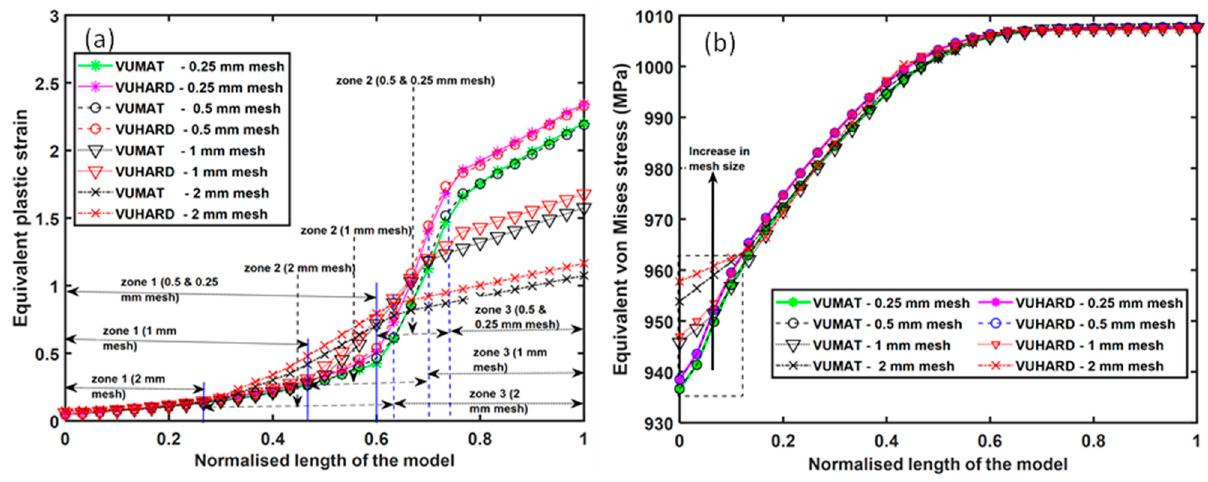
Figure 17. A typical equivalent ( a ) plastic strain and ( b ) von Mises stress distribution along the length of the numerical model with different mesh densities simulated at a velocity of 4 m/s for 0.001 s and at a temperature of 298 K.